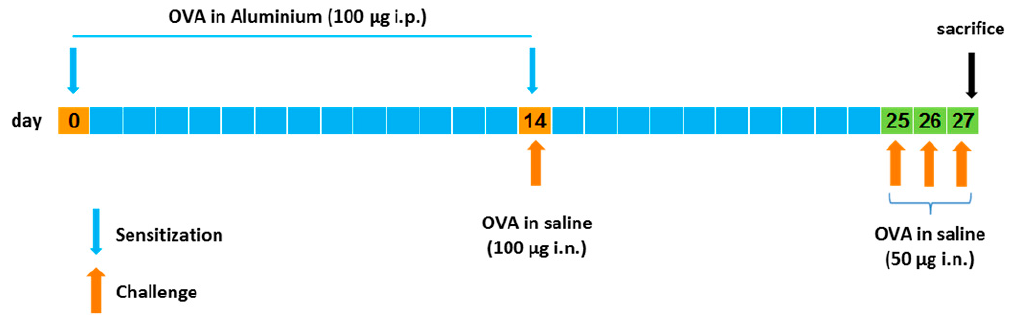
Figure 2. Schematic representation of the experimental allergic lung inflammation induction in mice as performed in this study.